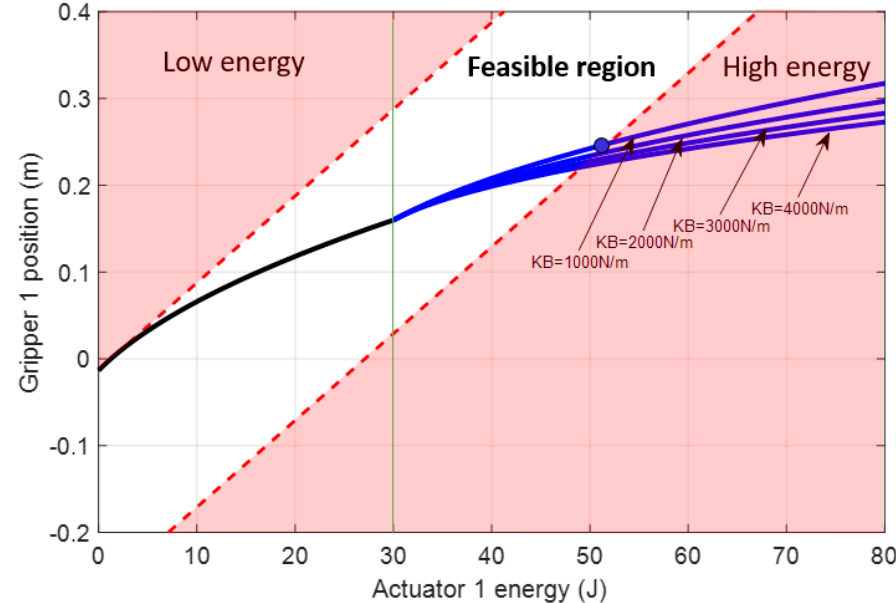
Figure 15. Feasible region of the energy imposed by actuator 1 for setting the position of the gripper attached to its compliant actuator without closing the gripper (black line) and with the gripper closed around a rigid solid (blue line). Four di ff erent springs were analyzed for cable section 1 B . The contact was produced at 30 J, or L 21 = 0.16 m (green line), and consequently, the gripper was determined to be closed. Boundaries were applied for the case of K B = 1000 N/m .